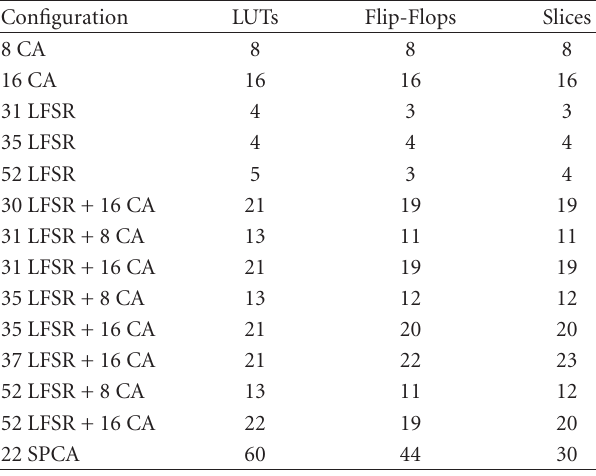
Table 2: FPGA resource utilized by the CAs.